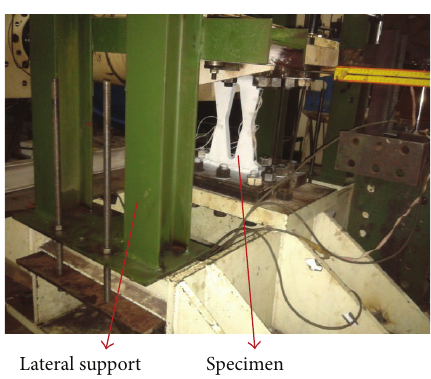
Figure 7: Front view of experimental setup.